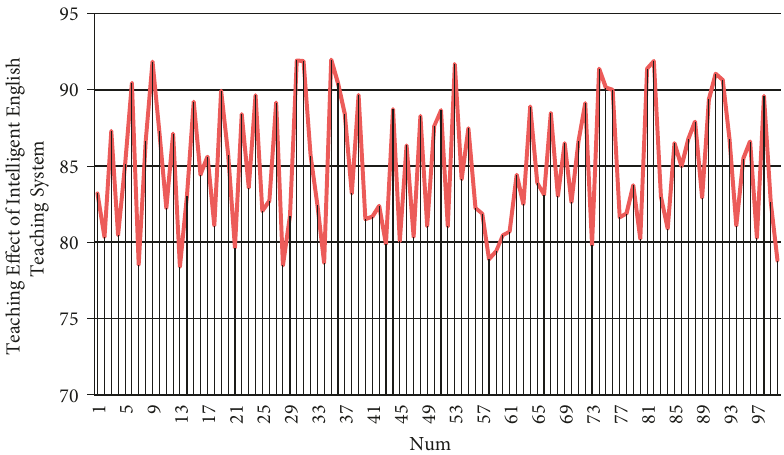
Figure 16: Teaching effect of intelligent English teaching